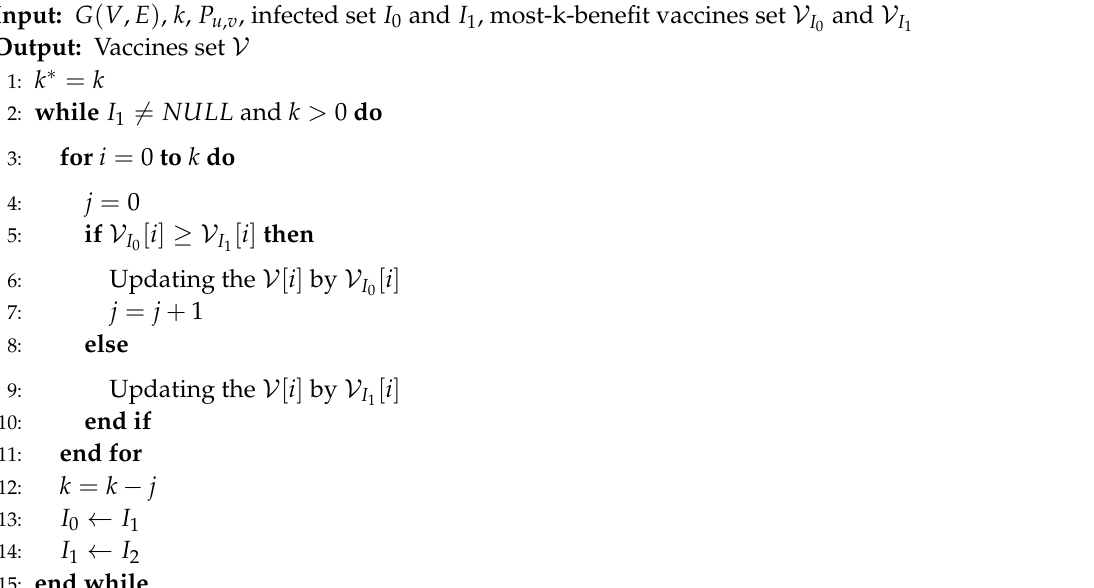
Algorithm 2 Find the most valuable set of